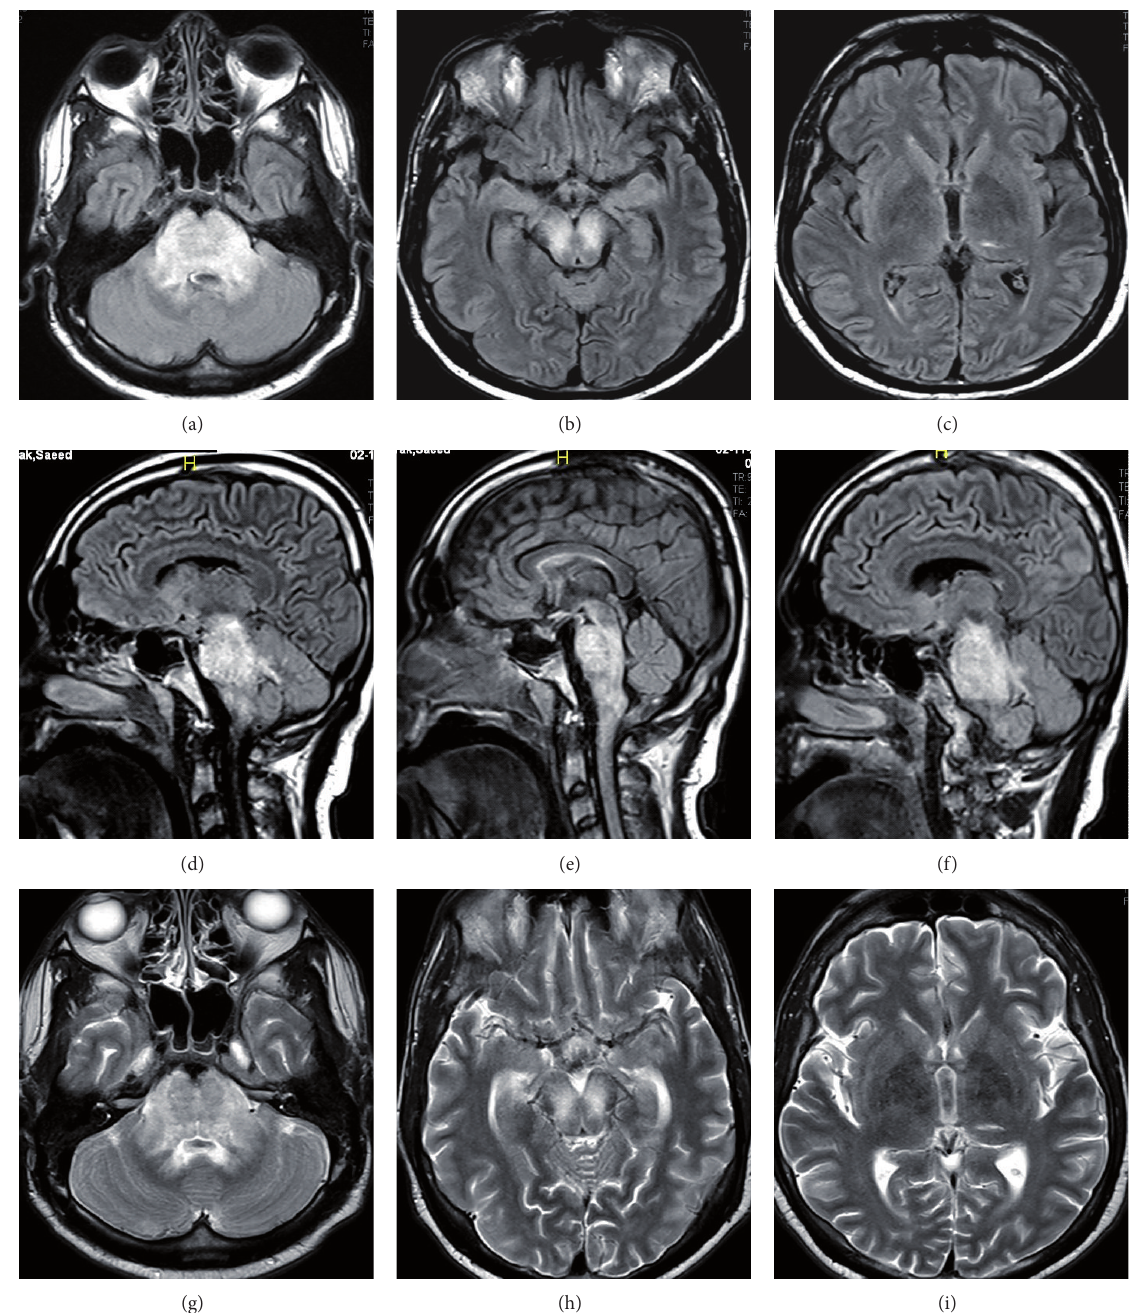
Figure 2: Noncontrast MRI showing swollen Pons with isolated high signal intensity of the whole Pons and midbrain in fluid attenuated inversion recovery (FLAIR) axial ((a)–(c)), sagittal ((d)–(f)), and T2-weighted (T2WI) ((g)–(i))